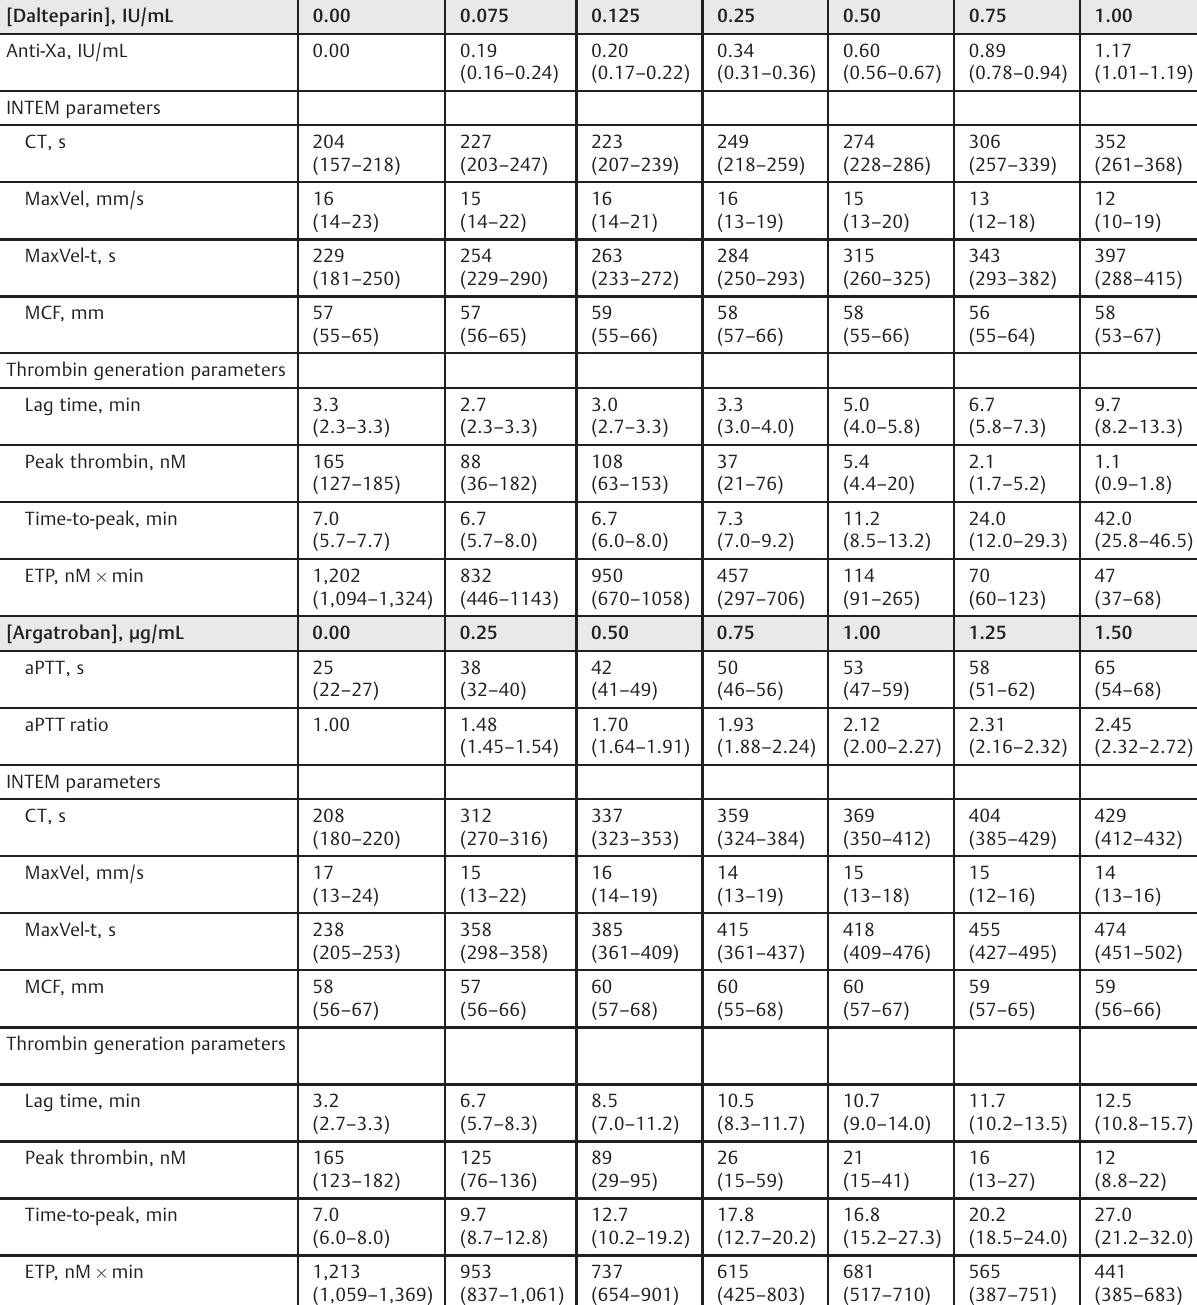
Table 2 Effect of increasing plasma concentrations of dalteparin (0.00 to 1.00 IU/mL) and argatroban (0.00 to 1.50 µg/mL) on anti- factor Xa (anti-Xa), activated partial thromboplastin time (aPTT), INTEM parameters, and thrombin generation parameters